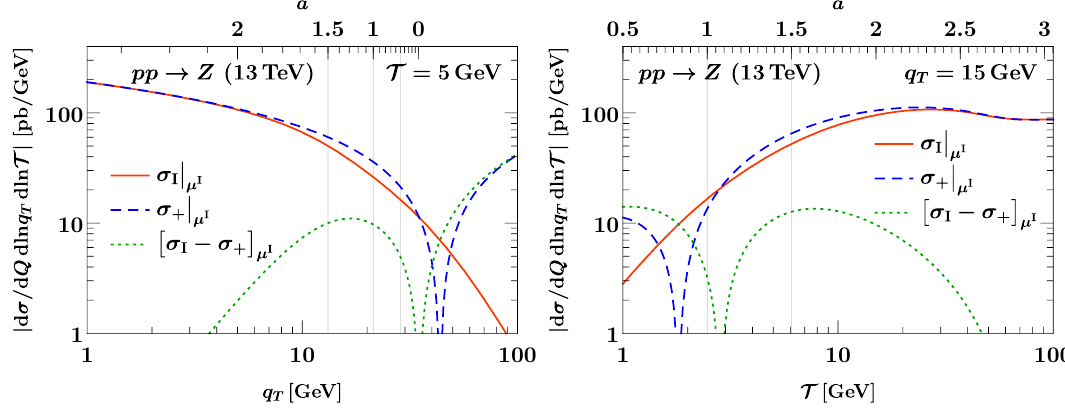
Figure 7 . Singular/nonsingular comparison between SCET I and SCET + at NNLL as a function of q T for (cid:12)xed T = 5 GeV (left) and as a function of T for (cid:12)xed q T = 15 GeV (right). The orange solid lines show the full SCET I result including resummation. The dashed blue lines show the corresponding SCET + singular limit with only SCET I resummation. The dotted green lines show their di(cid:11)erence, corresponding to the power corrections indicated in eq. (3.1). The thin vertical lines indicate our choice of transition points ( a 1 ; a 2 ; a 3 ) with respect to the regime parameter a (upper horizontal axis), as discussed in section 3.3.